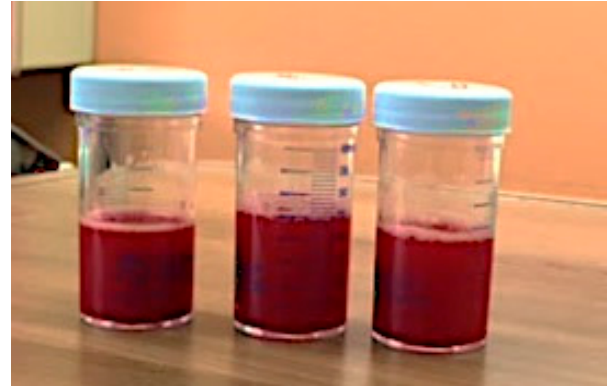
Figure 3. Case 1: Grossly bloody bronchoalveolar lavage fluid.